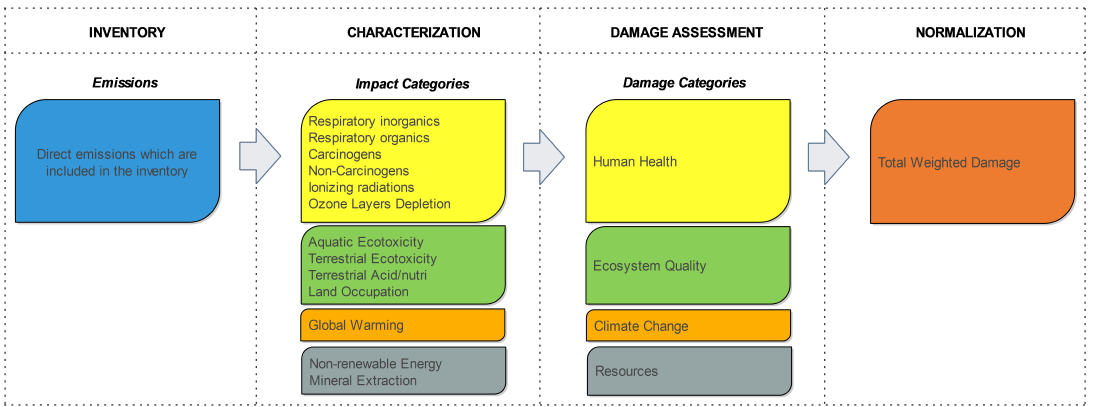
Figure 9. Structure of Life Cycle Impact